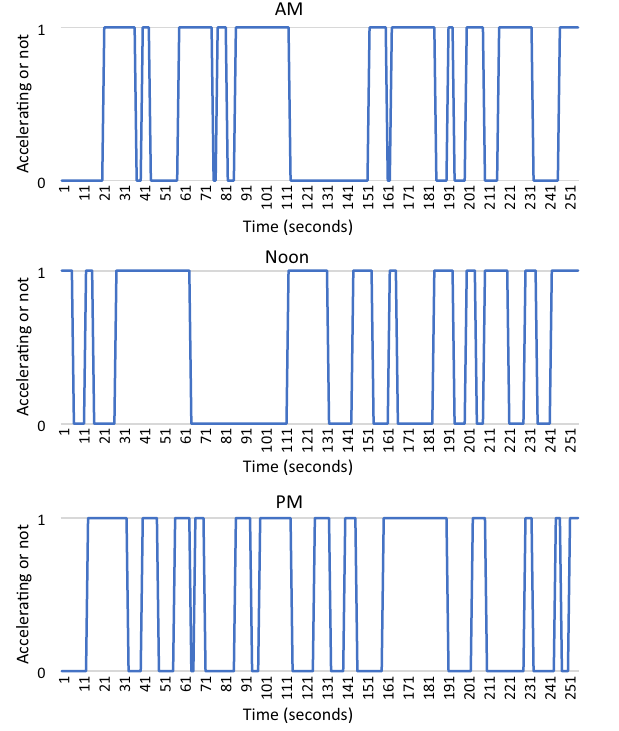
Figure 4. Time series acceleration